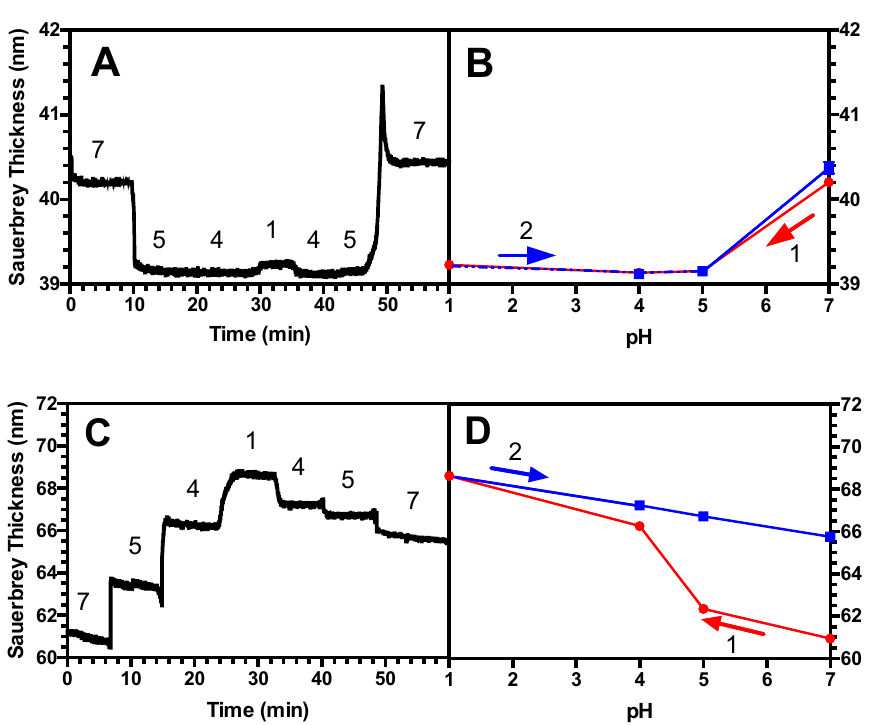
Figure 3. The same as in Figure 1 except for a 39 kDa PAA brush, grafting density σ = 0.45, again in 100 mM KCl; ( A , B ) are otherwise the same as in Figure 1, and in ( C , D ) the overlayer is a 25 kDa PEI. Error bars represent the standard deviation for N = 3 and if they are not visible, they are smaller than the symbols. The dashed line represents a connecting segment that falls on top of another segment.